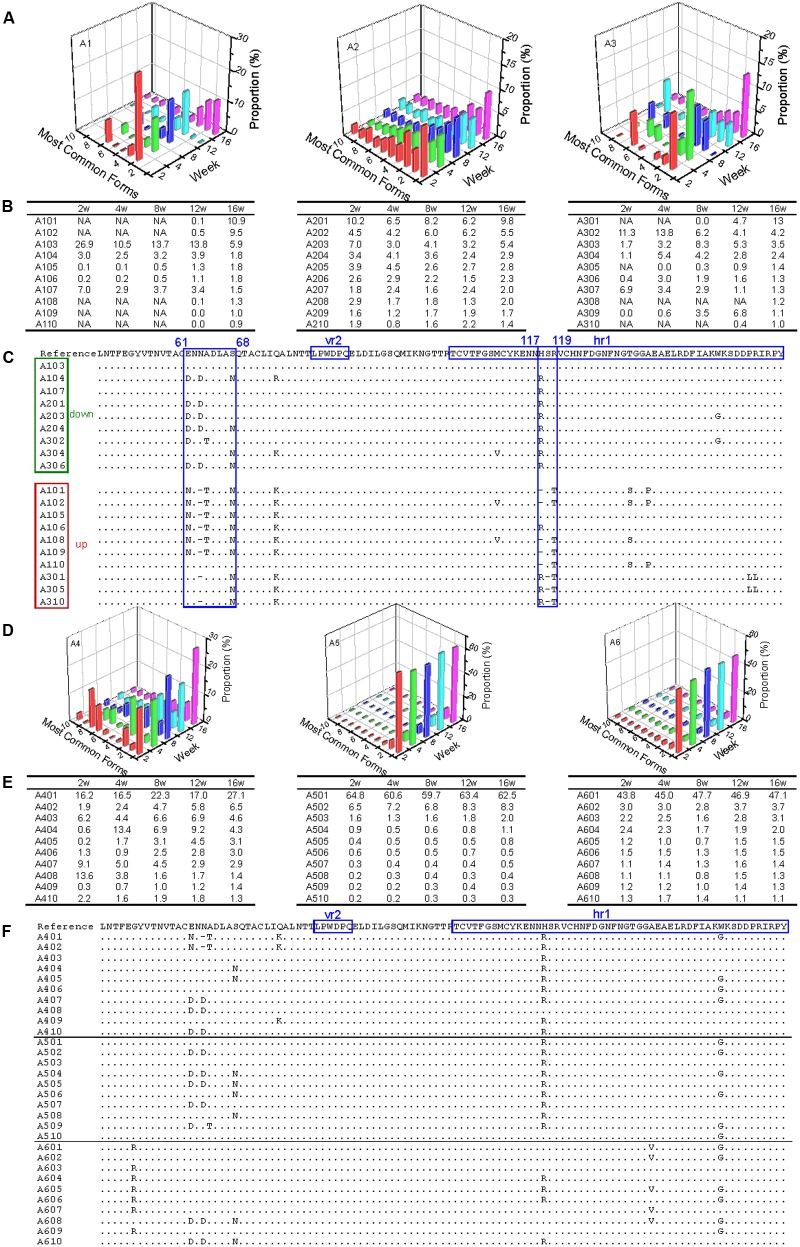
Evolutionary dynamics of gp85-A (vr2 and hr1 regions) genetic variants in antibody-positive and antibody-negative chickens during the first 16 weeks. In this figure, the variants are ordered according to their ranking at week 16. Chickens 1–3 were antibody-positive, and 4–6 were antibody-negative, as in Figure 1. In panels (B,C,E,F), the variants are named using the same strategy. For example, in A101, “A” refers to region A of the gp85 gene (gp85-A), the first number “1” means chicken 1, and “01” represents the top 1 variant at week 16; therefore, A101 represents the top 1 gp85-A variant of chicken 1 at week 16. In panels (B,E), NA means that no data are available. Panels (A,D) show the proportions of the top 10 variants of chickens 1–3 and 4–6 during the 16 weeks. Panels (C,F) show the amino acid substitutions of the variants of chickens 1–3 and 4–6, respectively. In the two panels, the dominant variant when inoculated is used as the reference, and the amino acid positions are numbered from the first codon of the mature gp85 protein. The two previously identified variable regions, vr2 and hr1, are highlighted. In panel (C), the representative variants are classified into two groups, down and up, in which the proportion of the variants decreases or increases with time, respectively. The most dominant variant in the inoculated stock is used as the reference, and the amino acid positions are numbered from the first codon of the mature gp85 protein.